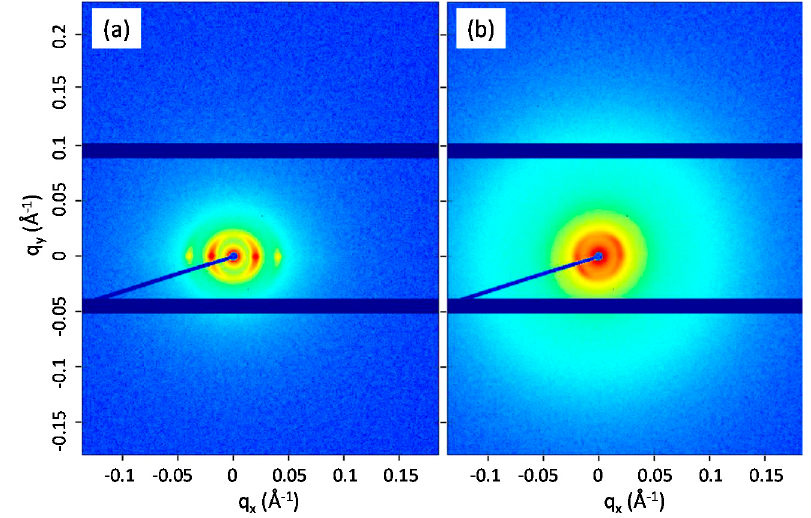
Figure 7. Small-angle x-ray scattering (SAXS) 2D scattering patterns of ( a ) LN3_A and ( b ) LN3_1_A.